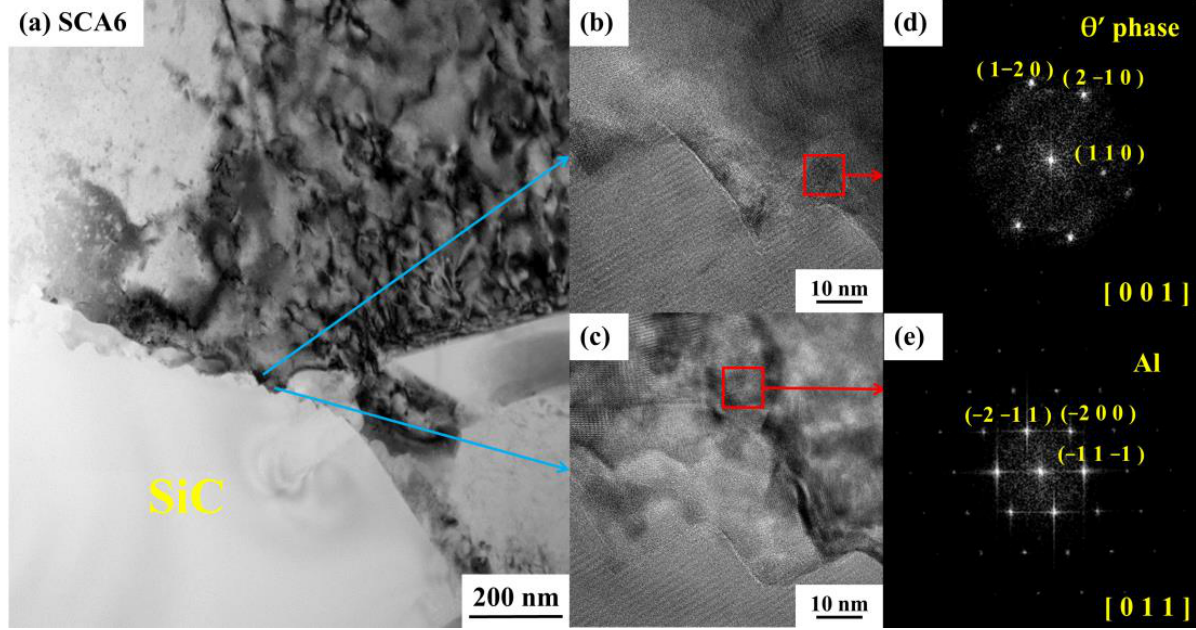
Figure 12. Micrographs of the 15%SiCp/2009Al composites treated by SCA6, ( a ) micrographs of SCA6 sample, ( b , c ) HRTEM micrographs of the selected areas in ( a ), ( d , e ) the FFT patterns of selected area in (b) and (c), separately.